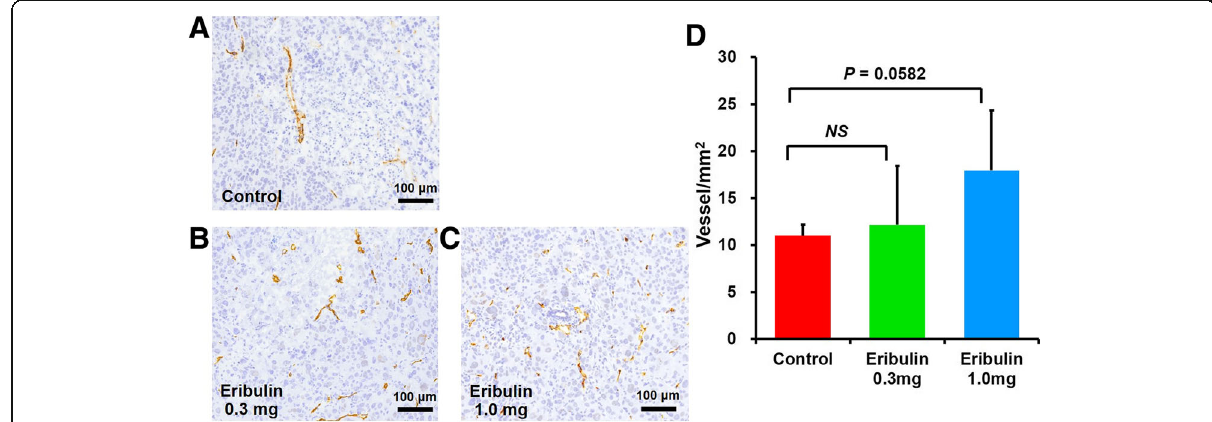
Fig. 4 Representative images ( a – c ) and quantitative analysis ( d ) of CD31 IHC in the ex vivo groups. Scale bar is 100 μ